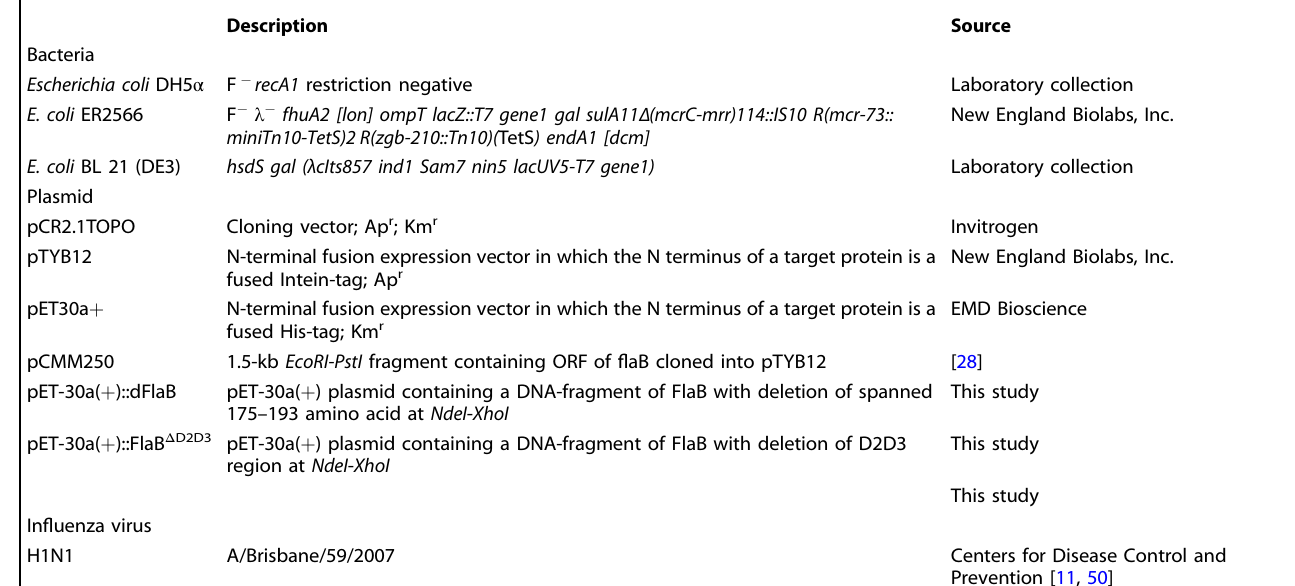
Table 1. Bacterial strains, plasmids, and in fl uenza